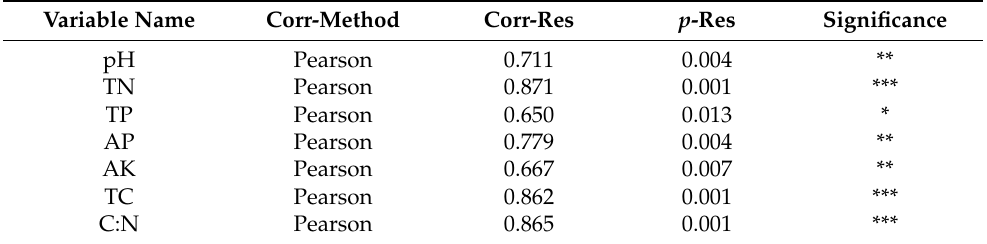
Figure 5. Effects of soil physicochemical properties on fungal communities. The effects of soil properties were tested on soil fungal communities: ( a ) RDA analysis (distance-based redundancy analysis) on phylum level; ( b ) Correlation analysis between soil properties and abundant taxa of fungi at phylum level; ( c ) RDA analysis on genera level; ( d ) Correlation analysis between soil properties and abundant taxa of fungi at the genera level. Table 1. Pearson correlation (at phylum level) between the Bray-Curtis dissimilarity score and soil properties using the mantel